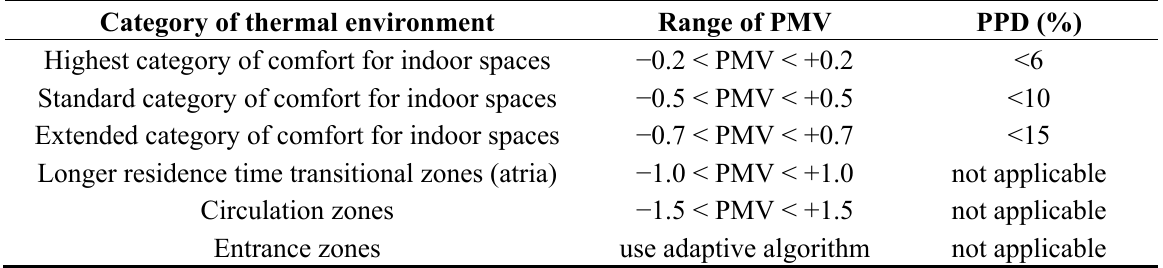
Table 9. Proposal for revised building categorizations used in comfort